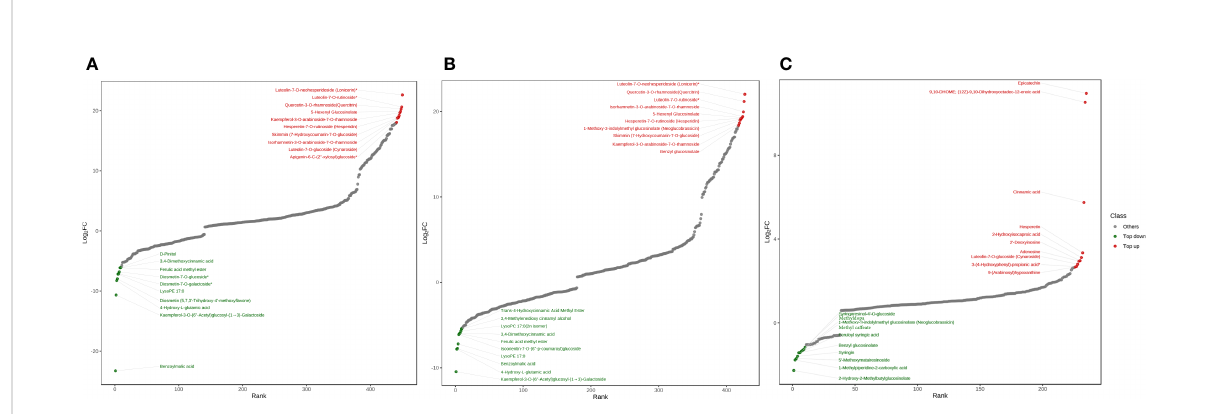
FIGURE 4 TopFc20 distribution diagram. (A) Low-altitude vs High-altitude. (B) Low-altitude vs Mid-altitude. (C) Mid-altitude vs